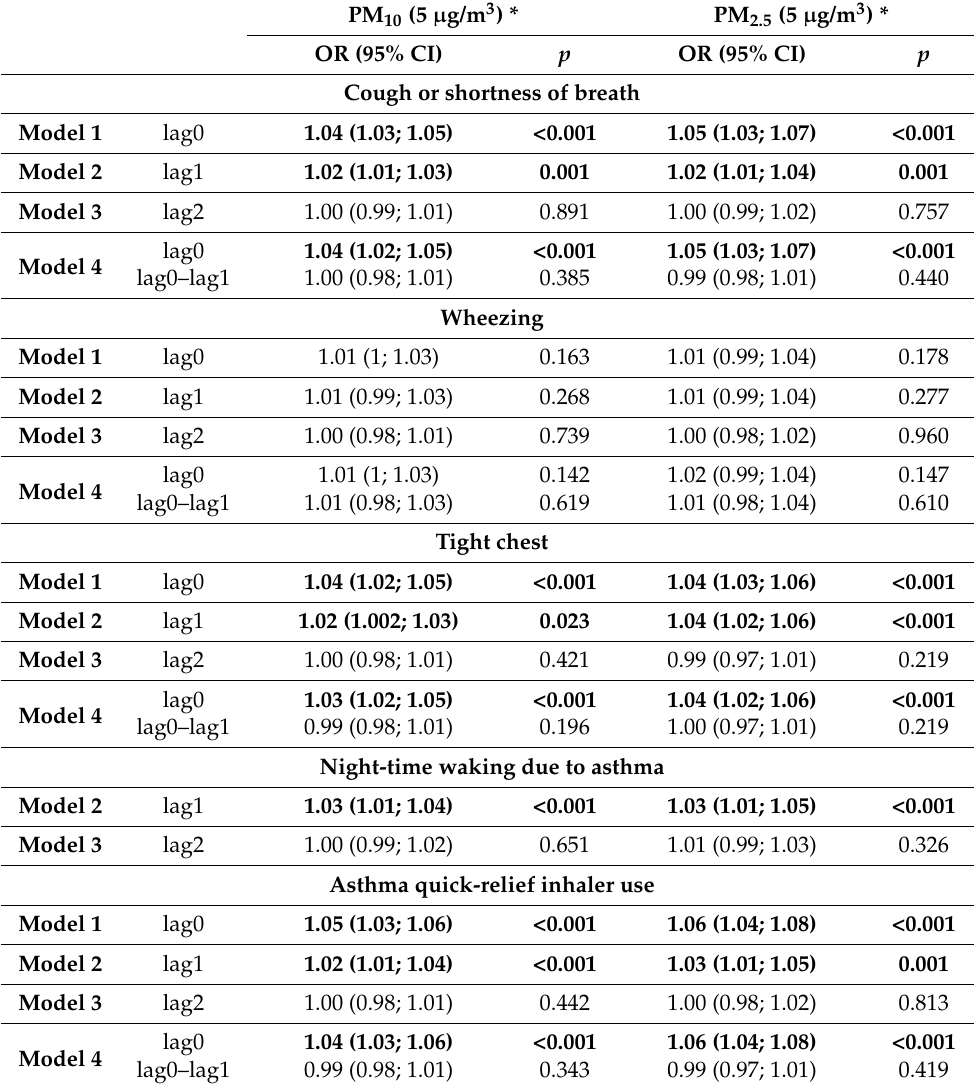
Table 3. Effect of PM 10 and PM 2.5 levels on asthma symptoms and medication